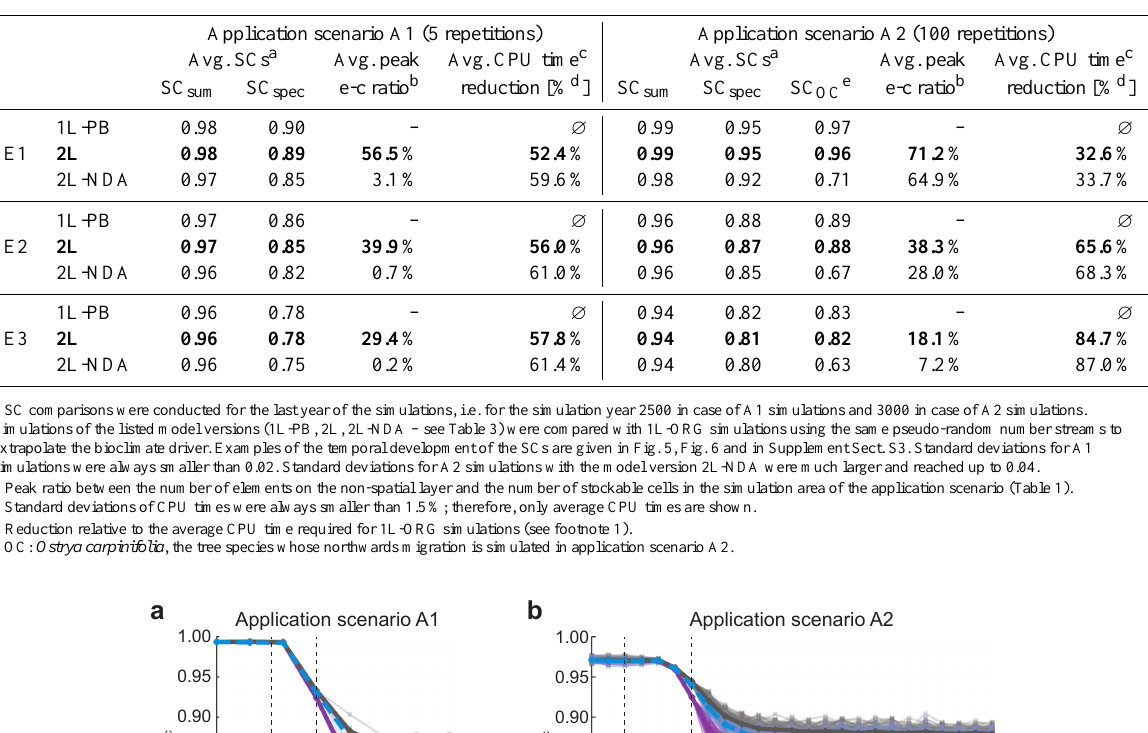
Table 5. Performance measures for simulations with both application scenarios (A1 and A2) and with all three sets of bioclimate types (E1–E3). For both scenarios, the table lists the mean similarity coefficients (SC) comparing results of the last simulation year from the three model versions (1L-PB, 2L and 2L-NDA) to 1L-ORG simulations for different target variables (biomass sum over all species, biomass per species and, for scenario A2, biomass of Ostrya carpinifolia ). In addition to the SCs, average peak element-cell ratios and mean CPU time reductions relative to 1L-ORG simulations are listed. All means for A1 stem from five repetitions, for A2 from 100 repetitions. SCs from 2L simulations were always very close to SCs from 1L-PB simulations, indicating that the dynamics in 2L simulations follow the dynamics in 1L-ORG simulations and that most of the deviations are due to the averaging of the bioclimate drivers for the bioclimate types. SCs from 2L-NDA are smaller, in particular for SC OC , underlining the importance to track migrating species.